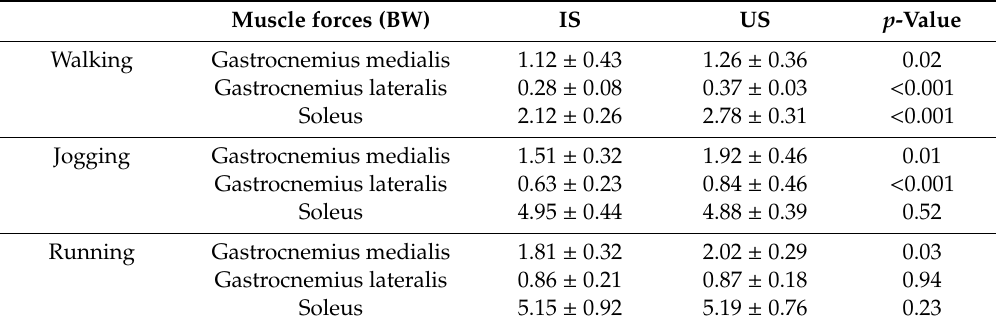
Table 5. The peak triceps surae muscle forces of the involved side (IS) and the uninvolved side (US) during walking, jogging and running movements, BW equals body